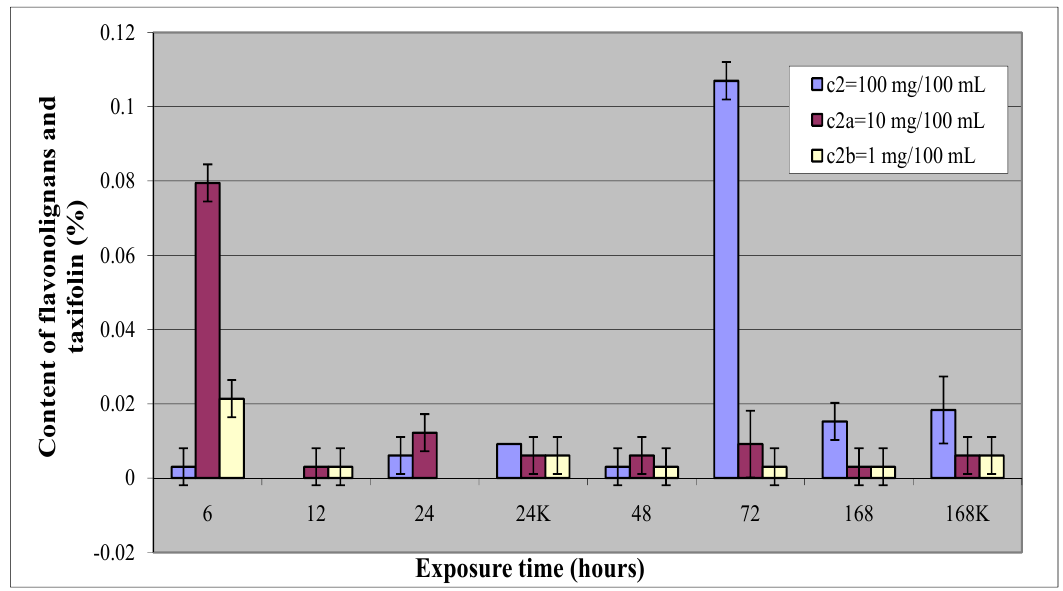
Exposure time (hours)